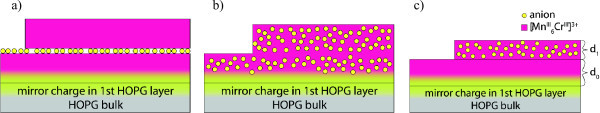
Adsorption models of [MnIII6CrIII]3+ on HOPG. The first layer of the SMM is stabilized by mirror charges having their origin in the metallic HOPG substrate.(a) Model #1: Alternating stacking of SMM and anions. (b) Model #2: anions are in between the layer. (c) Model #3: similar to model #2 but the first layer is free of anions due to the mirror charge of the substrate thus leading to different heights of the first layer d0 and the consecutive ones d1...dn.